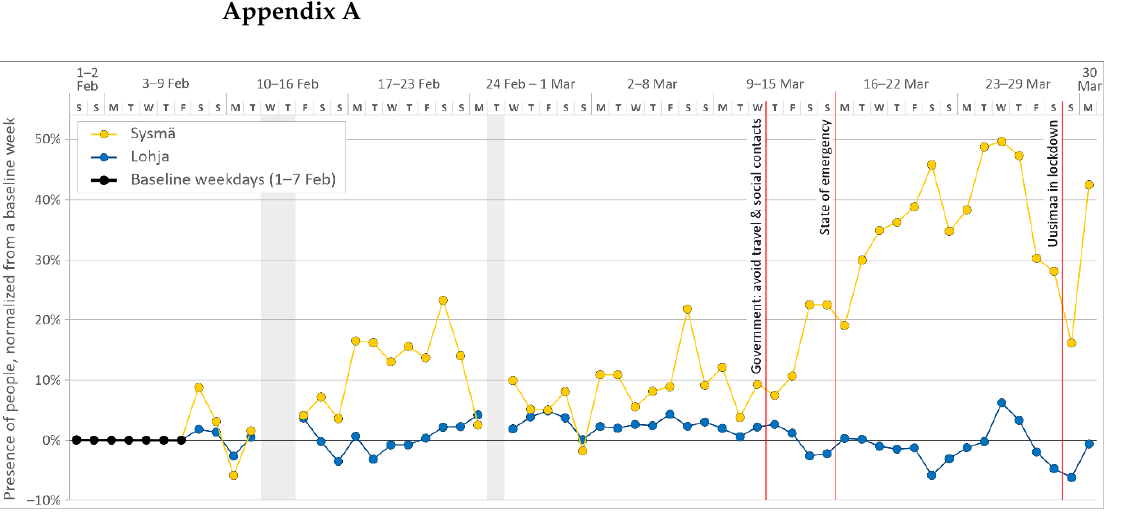
Figure A1. The varying presence of people at municipality level compared to the baseline weekdays (1–7 February 2020) in the municipality of Lohja and Sysmä.